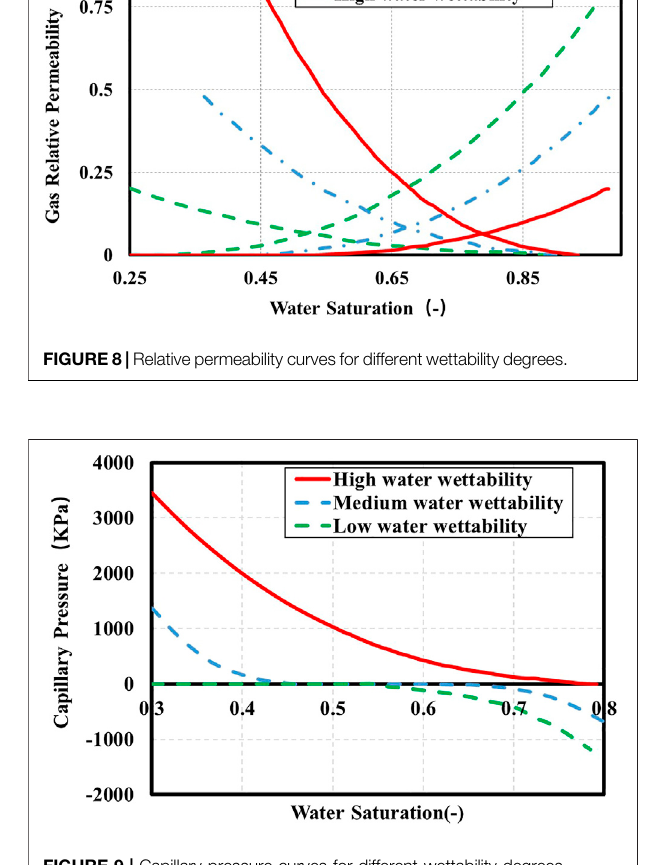
FIGURE 9 | Capillary pressure curves for different wettability